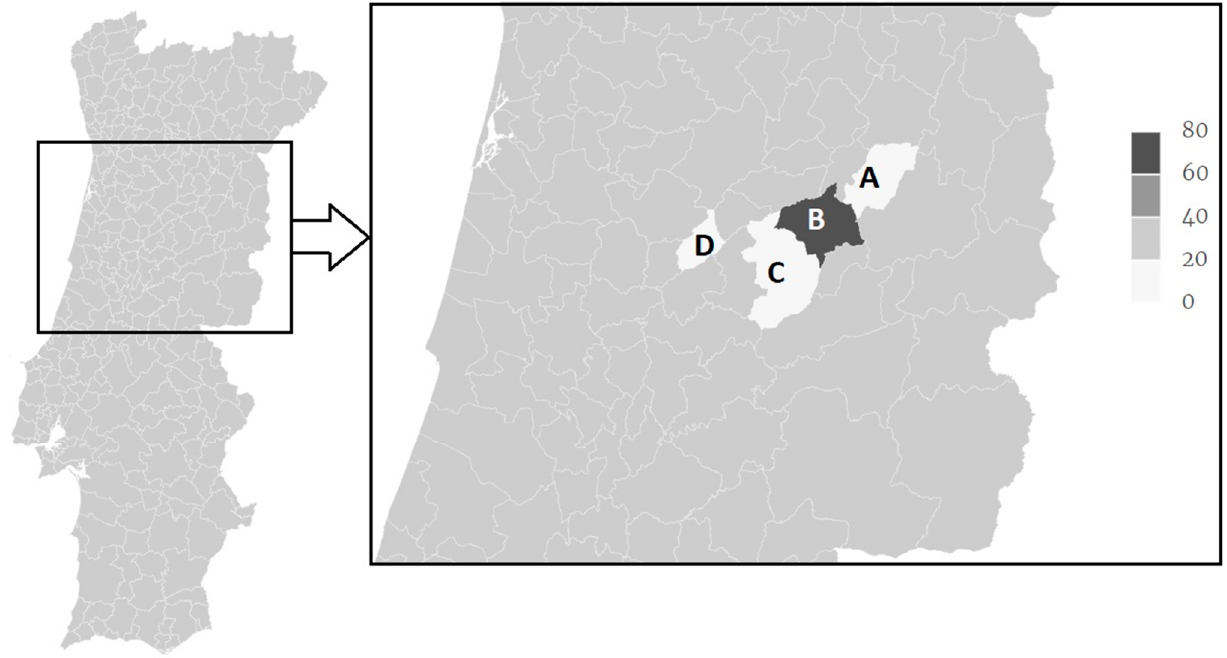
Figure 1. Distribution of F. hepatica IgG seropositivity Serra da Estrela sheep sampled in the years 2015 and 2016 in Celorico da Beira (A), Gouveia (B), Seia (C) and Carregal do Sal (D) municipalities.